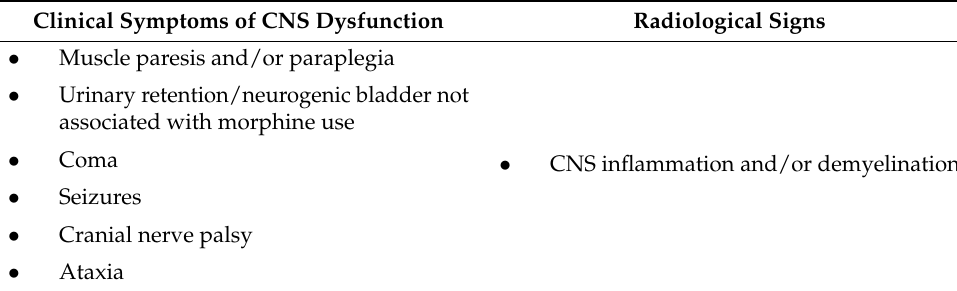
Table 1. Criteria of severe CNS neurotoxicity.